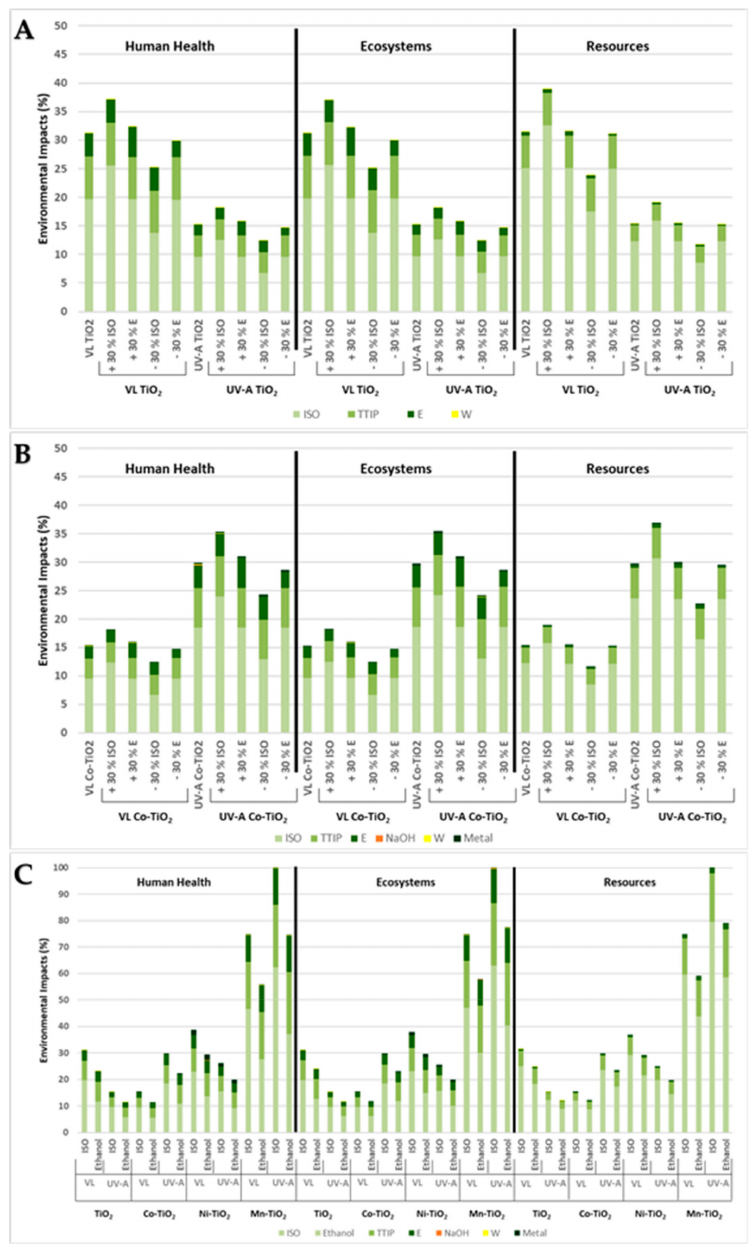
Figure 6. Relative environmental impact for sensitivity analysis of undoped ( A ), Co–TiO 2 ( B ) photocatalyst and comparison of the substitution of ISO with Ethanol ( C ) in MO degradation, under either UV-A or visible-light (VL)